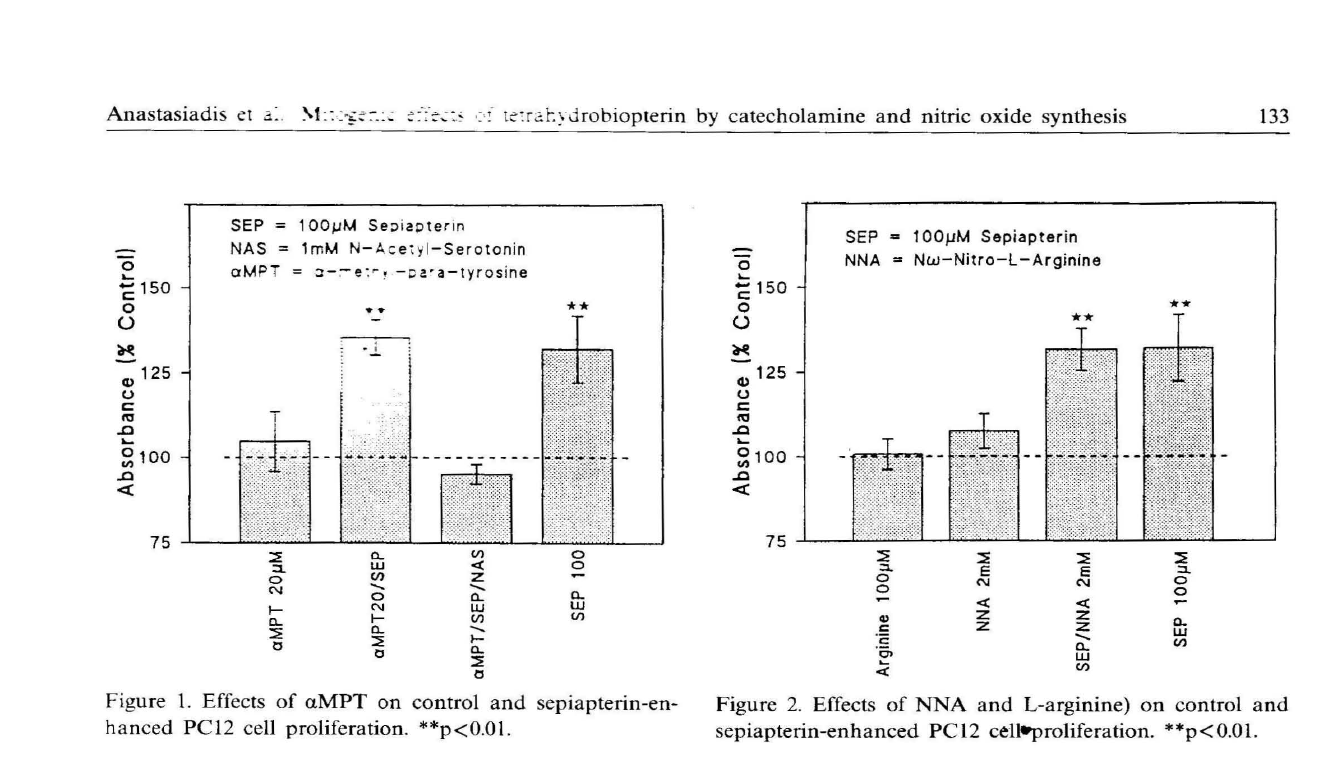
Figure 2. Effects of NNA and L-arginine) on control and sepiapterin-enhanced PC 12 cel~roliferation, **p< 0.01.